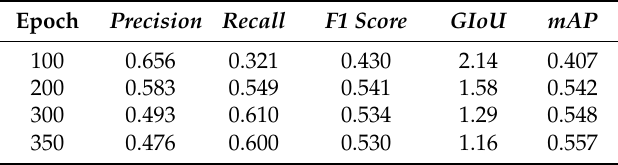
Table 2. Training metrics at di ff erent iteration